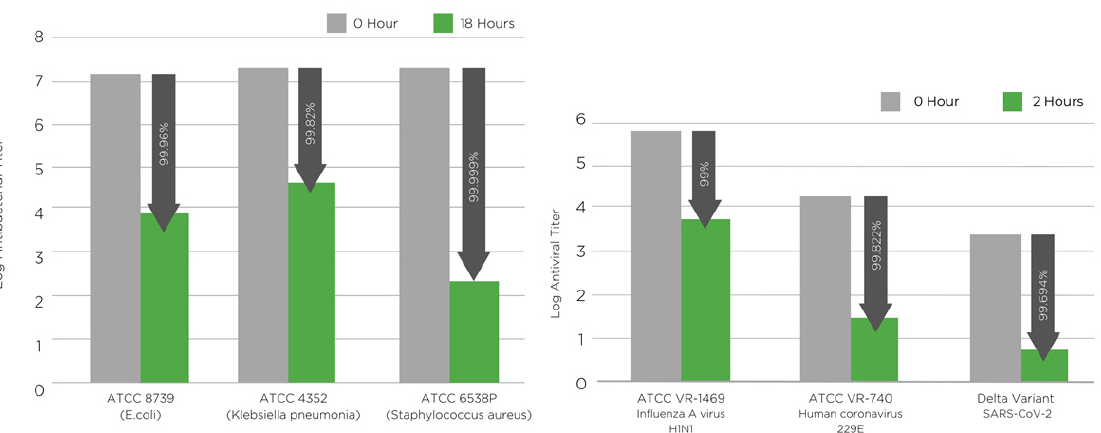
Figure 3. ( left ) Antibacterial activity of PLA NF filter media containing manuka triketone (5 wt.%) against S. aureus (ATCC 6538P), E. coli (ATCC 8739) and K. pneumoniae (ATCC 4352) tested according to ISO 20743:2013 [43]. ( right ) Antiviral activity of PLA NF filter media containing manuka triketone (5 wt.%) against influenza A, human coronavirus 229E and SARS-CoV-2 tested according to ISO 18184:2019 [44]. The arrows point at the inhibition of microbial growth. Table 5. Antibacterial reduction rate of PLA NF filter media containing manuka triketone (5 wt.%)